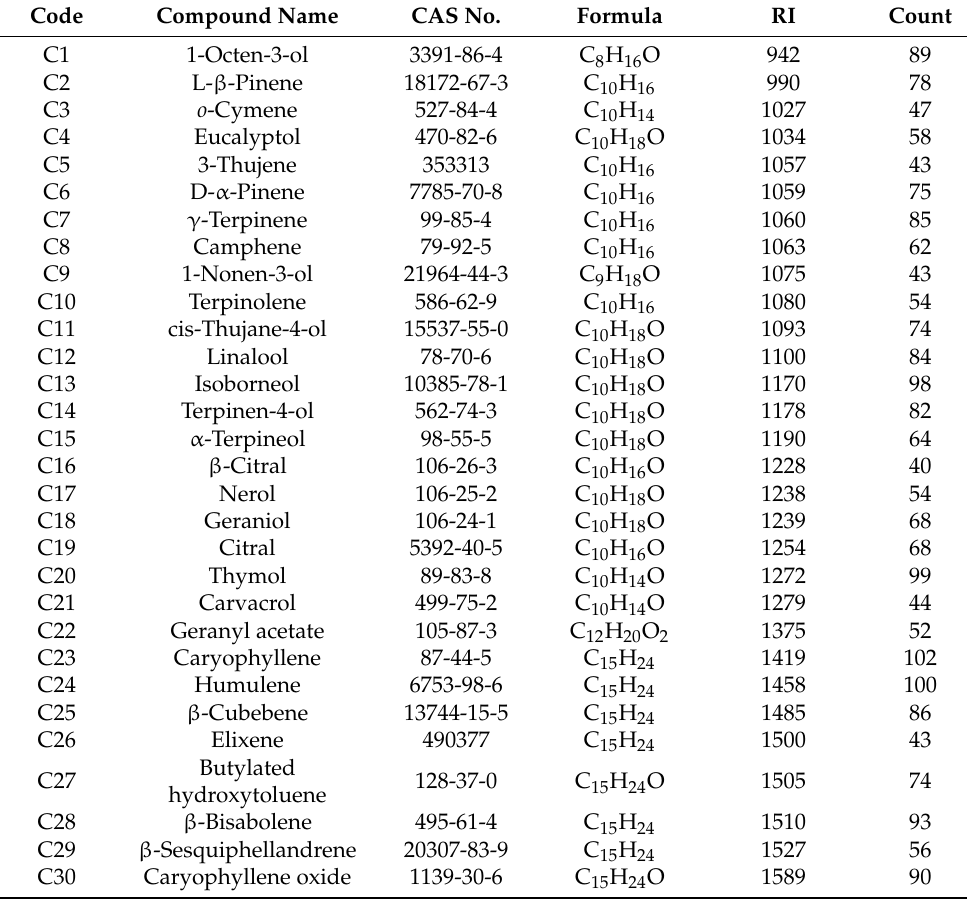
Table 2. Characteristics of essential oil components selected for PCA analysis.